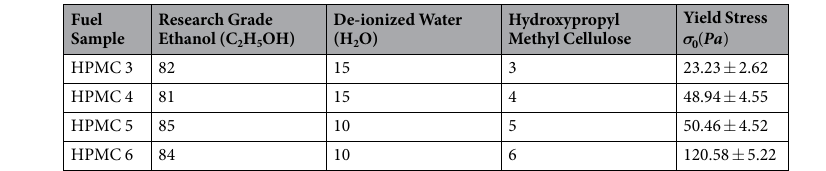
Table 1. Relative composition (in weight %) and yield stress of test